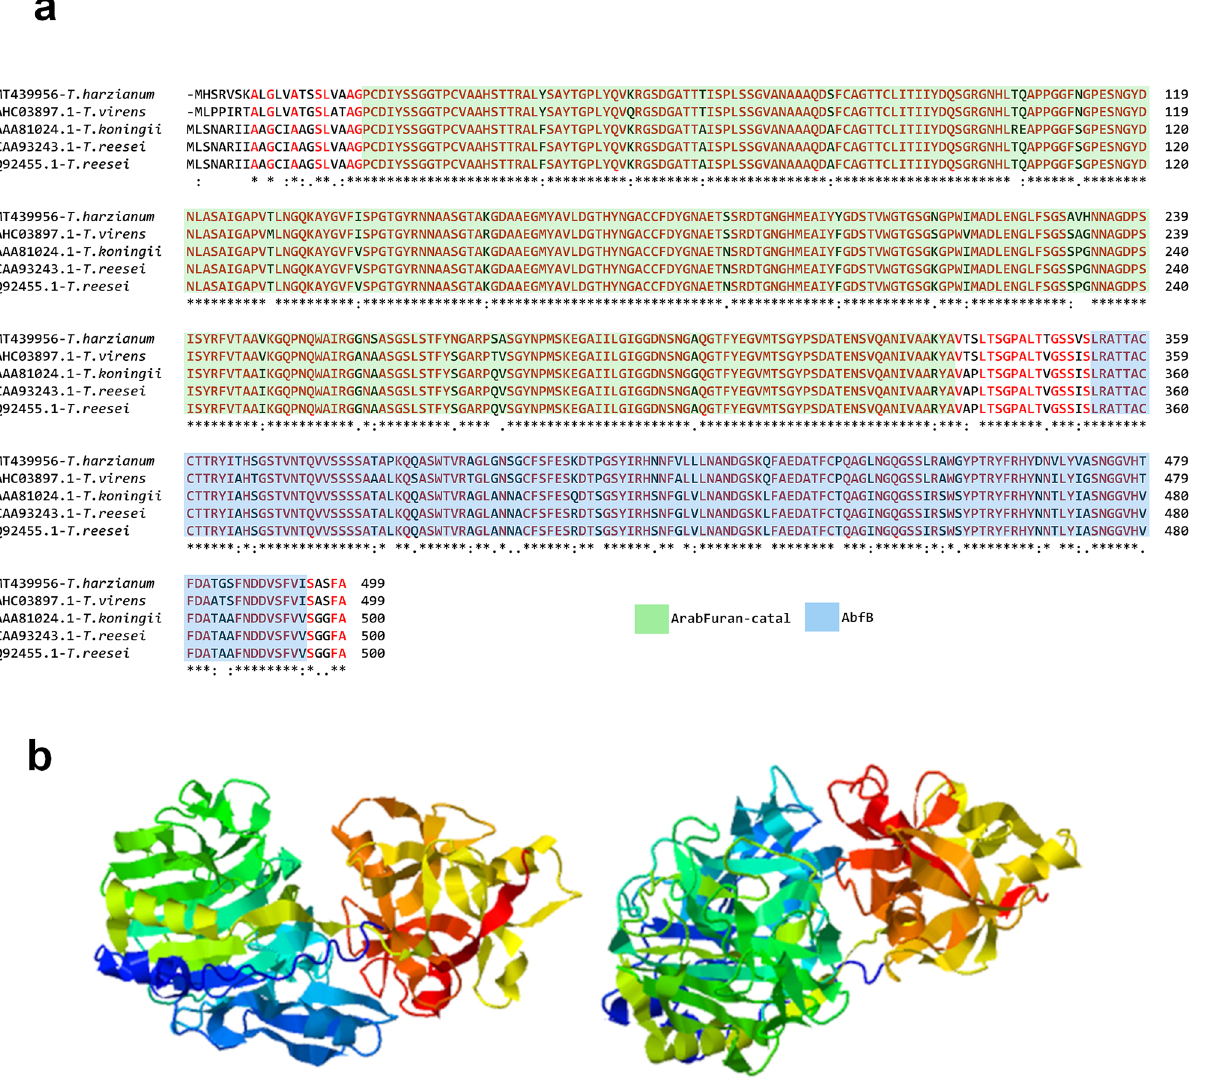
Figure 2. Alignment and structure prediction of ThABF. ( a ) Alignment of ThABF with other Trichoderma sequences belonging to the GH54 family. ( b ) Prediction of the ThABF structure by